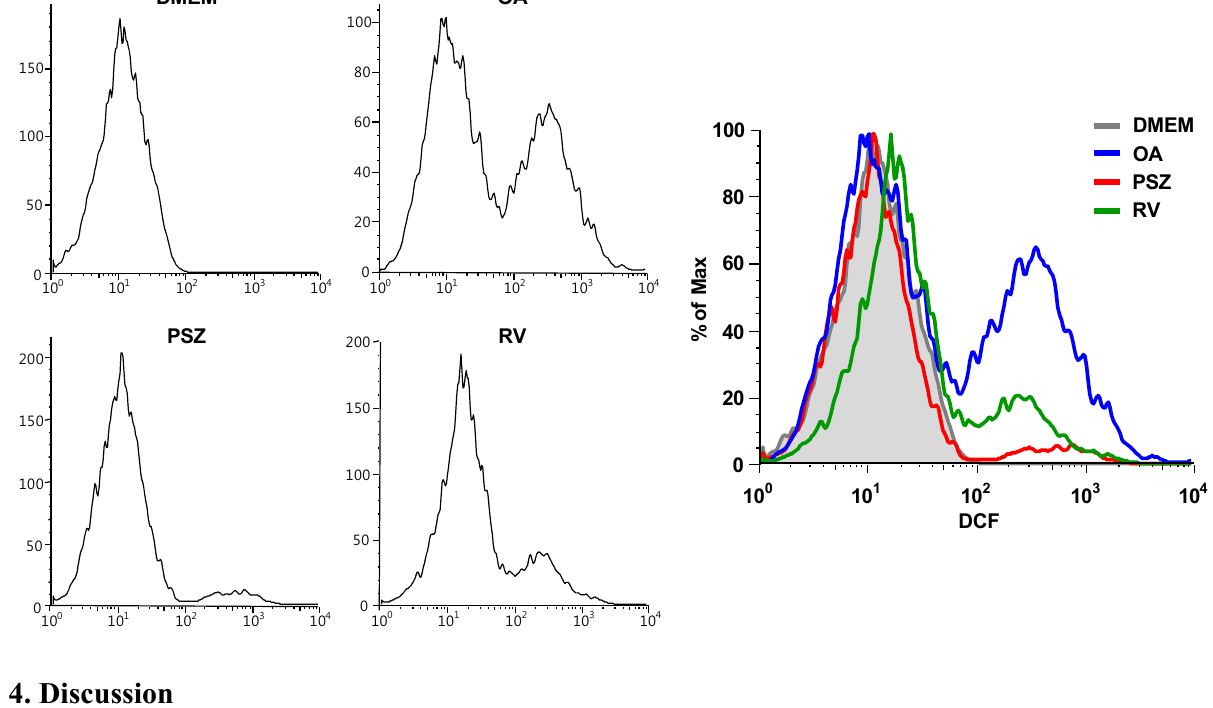
Figure 7. Effects of Pinus densiflora Sieb. et Zucc. (PSZ) on ROS-scavenging activity in oleic acid (OA)-induced HepG2 cells. HepG2 cells were treated with 100 μ g/mL PSZ. After treatment for 24 h, cells were harvested and stained with DCF-DA. Results are the mean ± SEM from three independent experiments. * p < 0.05 compared with the OA group. DMEM, control group; OA, oleic acid-treated group; PSZ, OA + Pinus densiflora Sieb. et Zucc.-treated group; RV, OA + resveratrol-treated